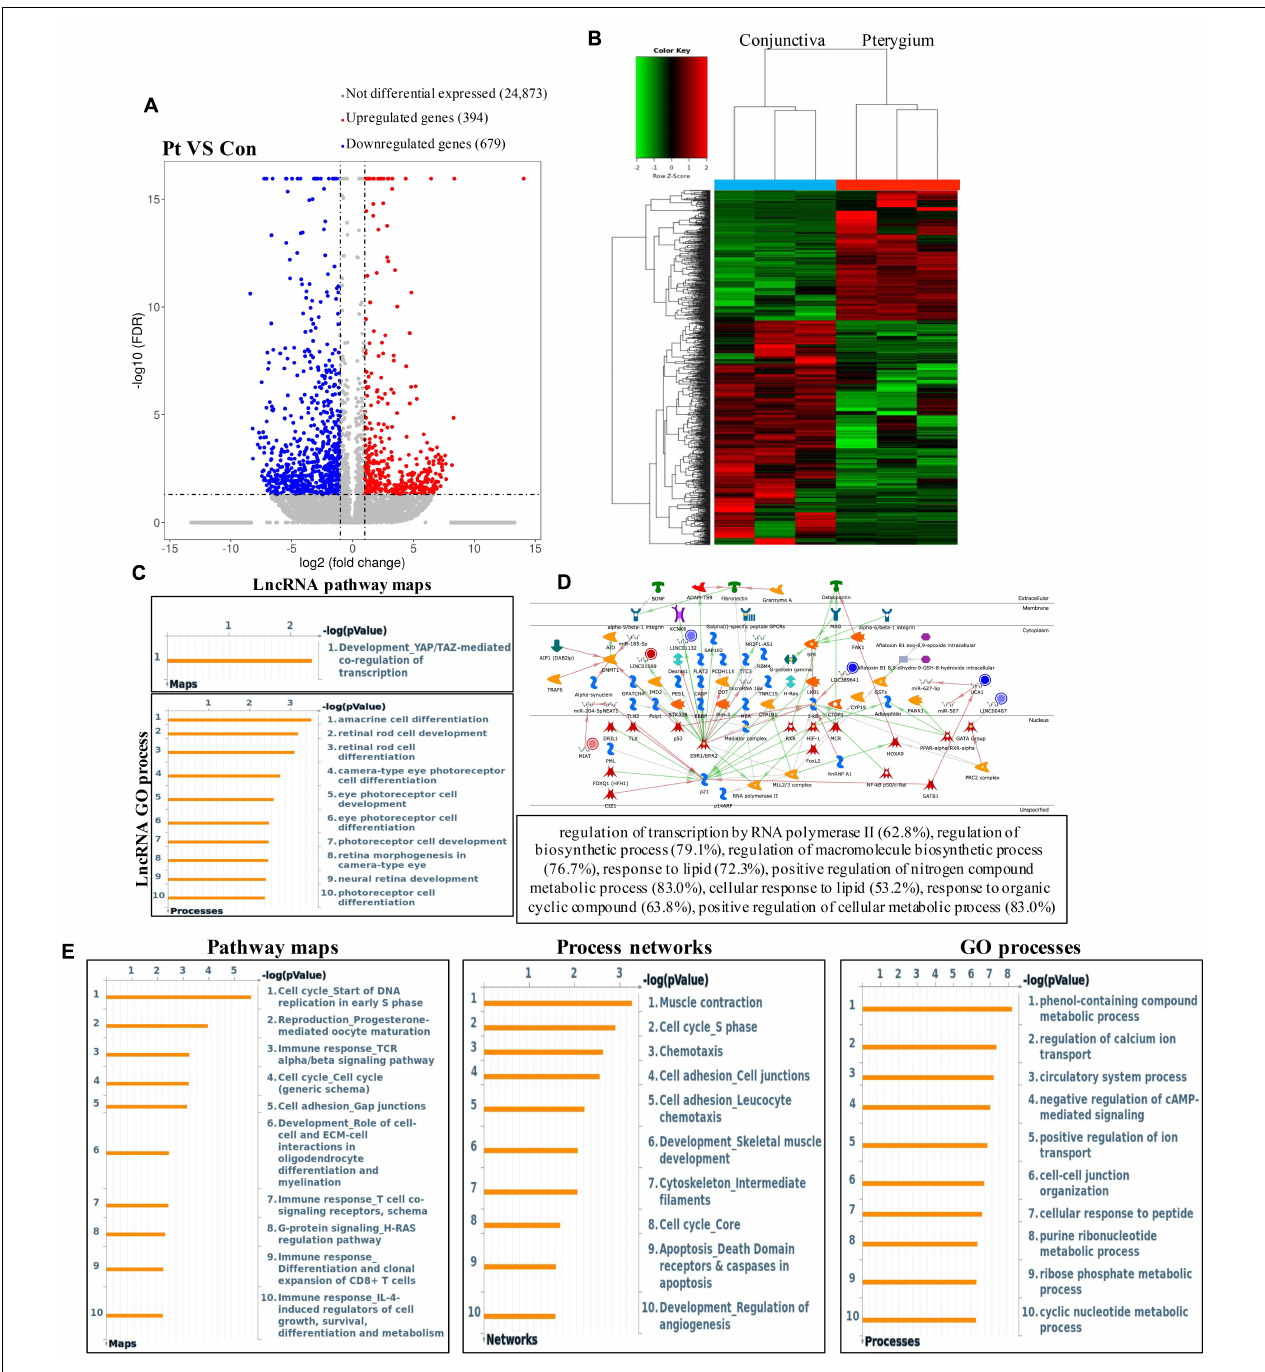
FIGURE 6 | Results of significant RNA of pterygium in RNA-seq data. (A) Volcano plots and (B) heatmap plots showing differentially expressed genes in pterygium vs. conjunctiva. Fold change ≥ 2 and P < 0.05. (C) GO processes and pathway maps analysis of significant lncRNA. (D) Top three scored networks analysis of significant lncRNA. (E) Pathway maps, process networks and GO processes analysis of significant mRNA. Left panel represents pathway maps, middle panel represents process networks and right panel represents GO processes.